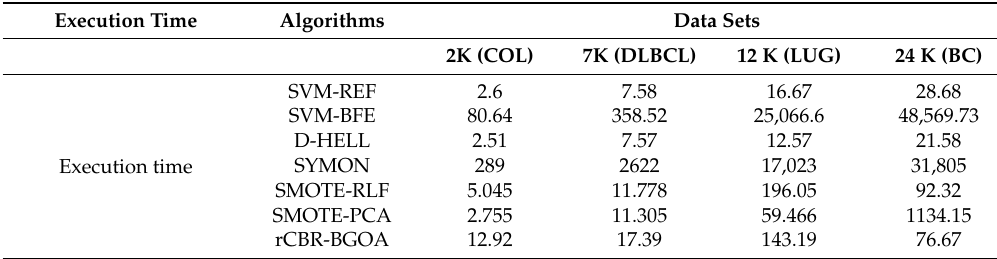
Table 8. The total execution time of rCBR-BGOA in comparison with similar methods across data